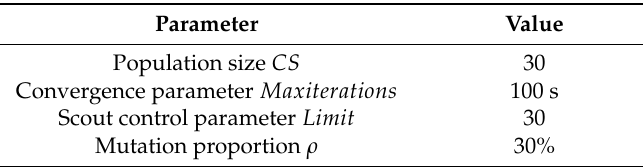
Table 3. The ABC-MOLA parameter values.